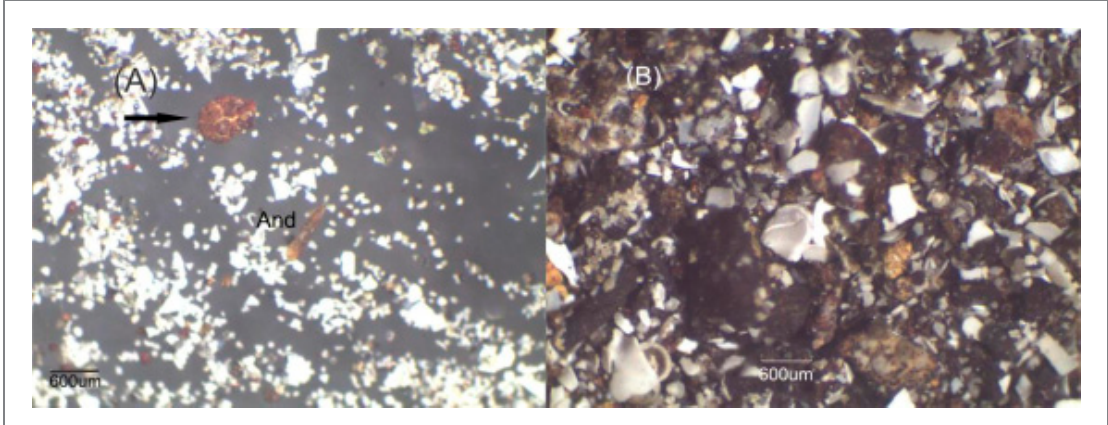
Figure 8 - (A): SIS-515, 156-162 depth, andalusite and oxidized mollusk shell. (B): ferruginous aggregates and mollusk shell SIS-515, 156-162. 8.09%, and K 1.04%) against Ca (22.67%), the latter